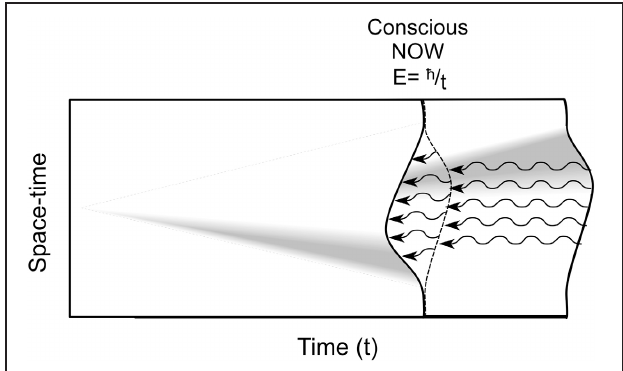
FIGURE 10 | Location or state of a particle/object is equivalent to curvature in underlying spacetime geometry. From left, a superposition develops over time, e.g., a particle separating from itself, shown as simultaneous curvatures in opposite directions. The magnitude of the separation is related to E , the gravitational self-energy. At a particular time t , E reaches threshold by E = ¯ h / t , and spontaneous OR occurs, one particular curvature is selected. This OR event is accompanied by a moment of conscious experience (“NOW”), its intensity proportional to E . Each OR event also results in temporal non-locality, referring quantum information backward in classical time (curved